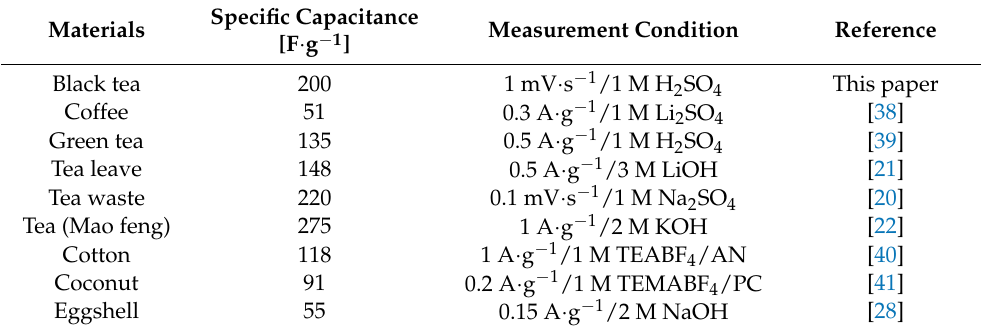
Table 3. The electrochemical performance of various biomass-based